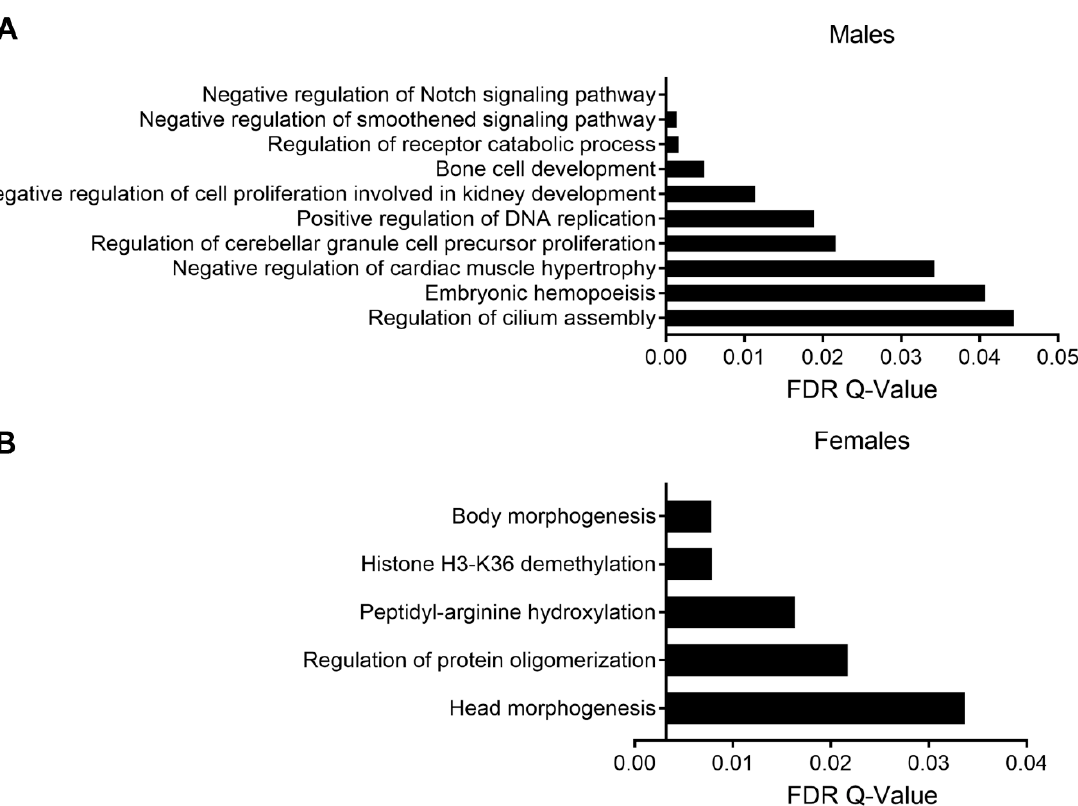
Figure 5. GREAT pathway analysis of DMRs in males ( A ) and females ( B ). Pathways are arranged from most significant (top) to least significant (bottom).